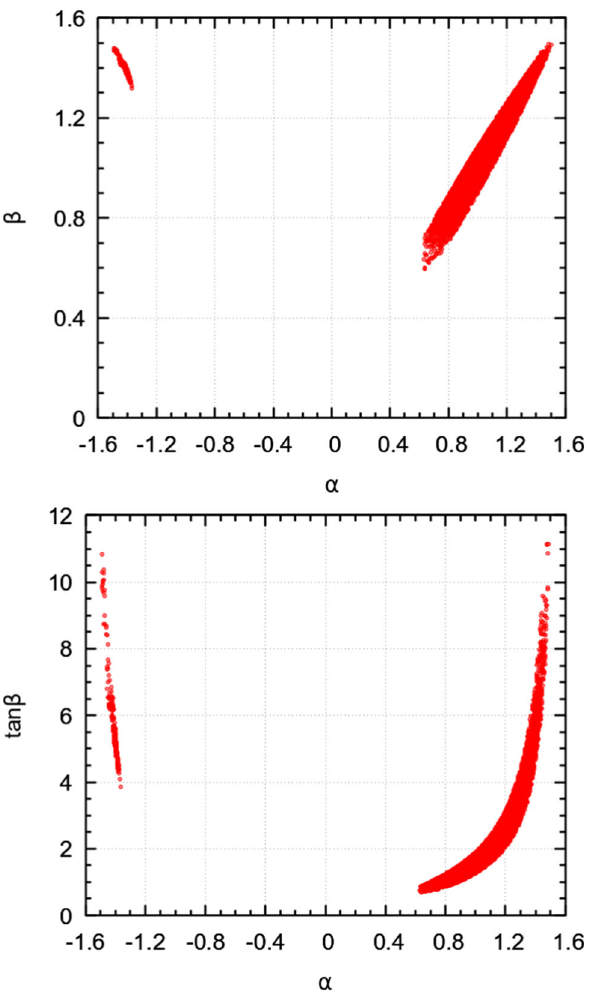
Fig. 3 Upper panel: correlation between α and β ; Lower panel: corre- lation between α and tan β